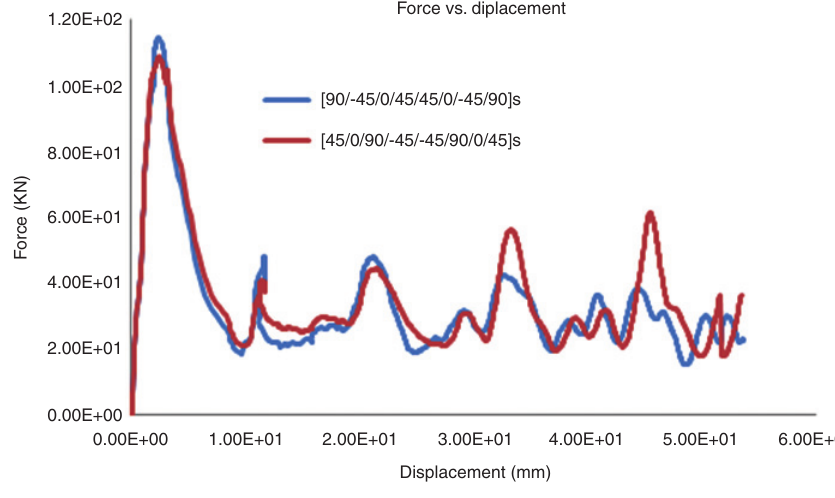
Figure 7 Force versus displacement at 8 m/s comparisons. Table 4 Pick load and average impacting load for each stacking sequence at maximum speed. Quasi-static